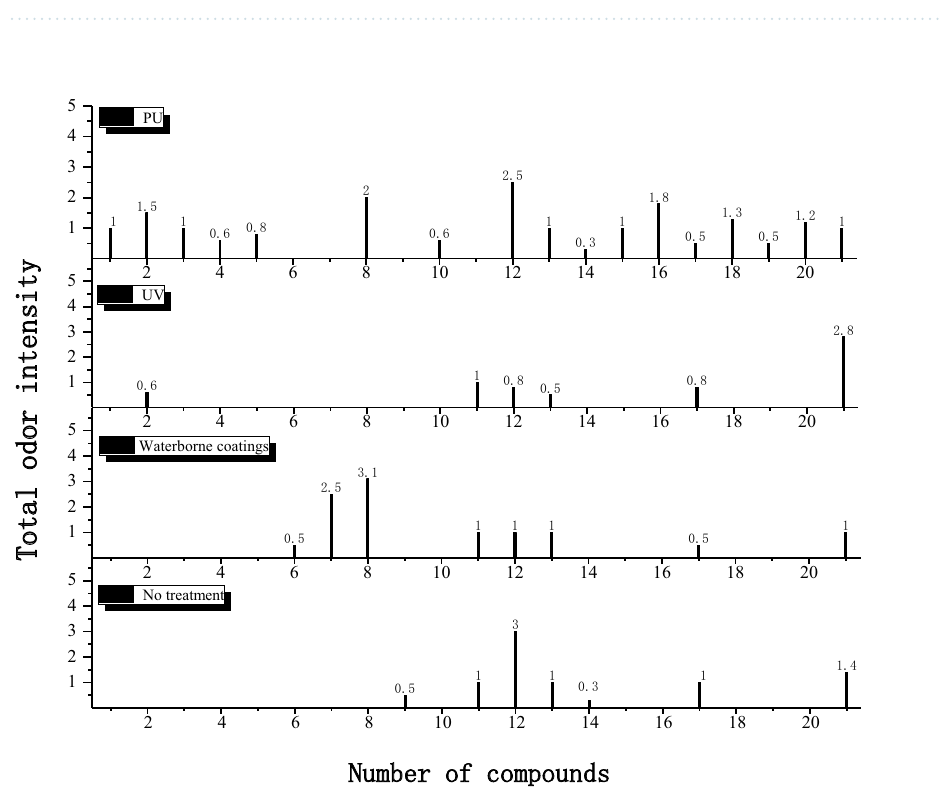
Figure 2. Odor-active compounds of Xylosma racemosum (Sieb. et Zucc.) Miq. with different lacquer decorations (The numbers correspond to the numbers provided in Table